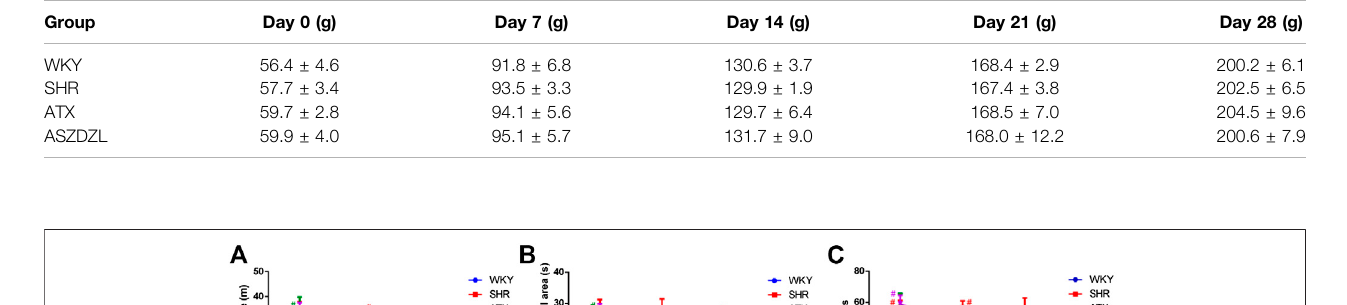
Frontiers in Pharmacology |